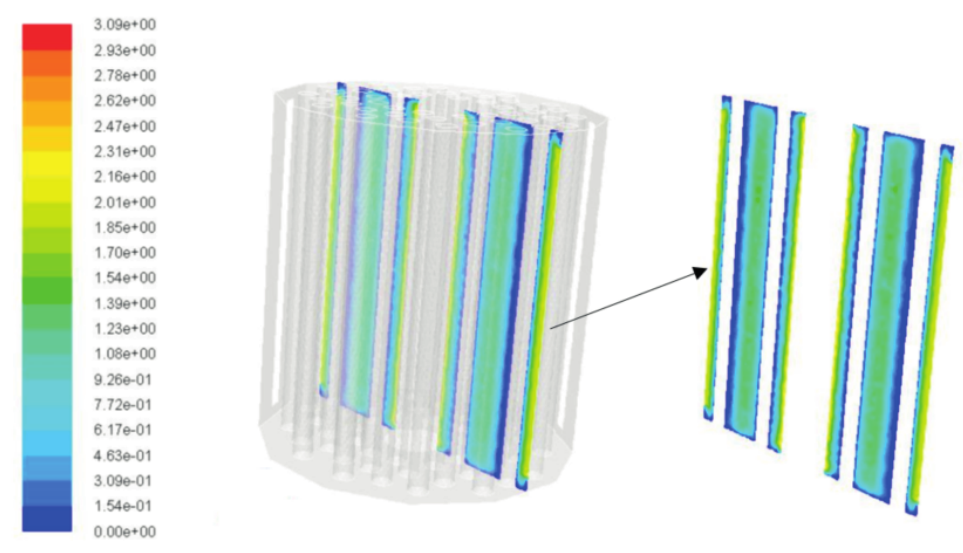
Figure 8: Velocity distributions [m s -1 ] inside the mSOFC stack at the inlet air velocity of 2 m s -1 .